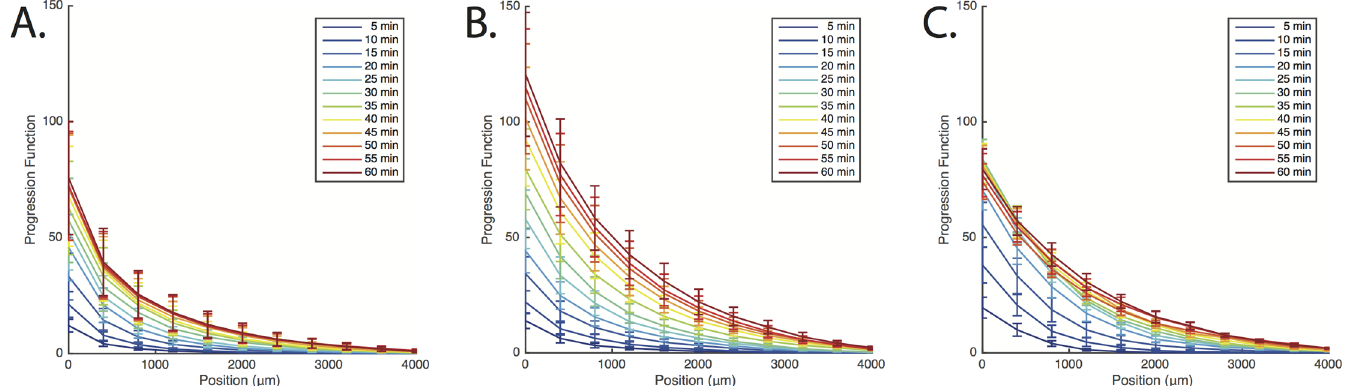
Fig 5. The progression of bacteria in the lateral channels. The graphs show at different times the so-called progression function, i.e. the distribution function of the number of bacteria cumulated from the position indicated on the abscissae up to the end of the channels on the side of the reservoirs. Curves were obtained using five different experiments. Panels A, B and C show the progression function for a gradient of aspartate, of serine, of aspartate with a background of serine, respectively. All the gradients go from 0 (at the entry of the channel) to 1mM.